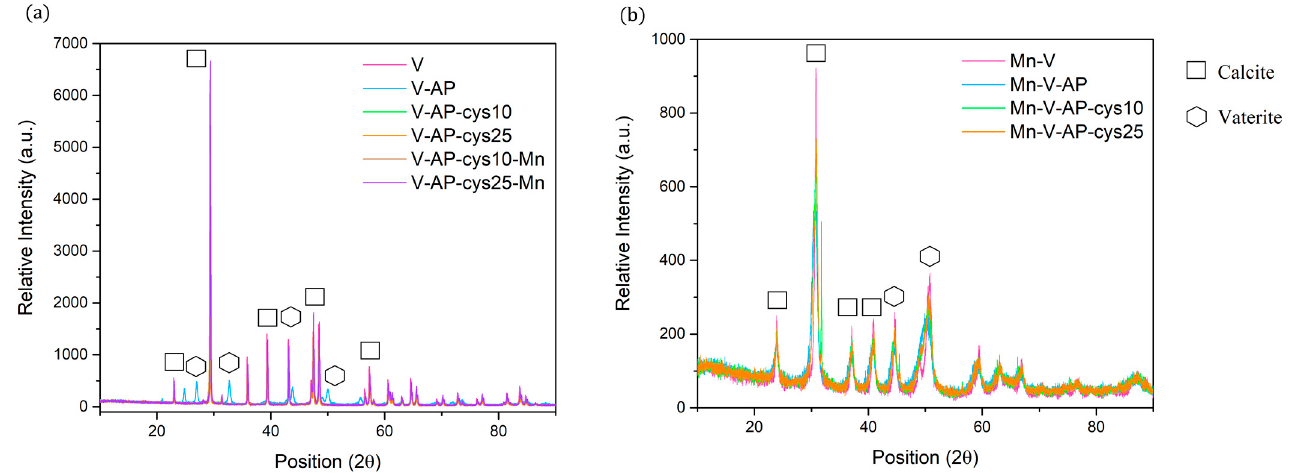
Figure 3. Comparative X-ray diffraction diffractogram for ( a ) V series, ( b ) Mn-V series.